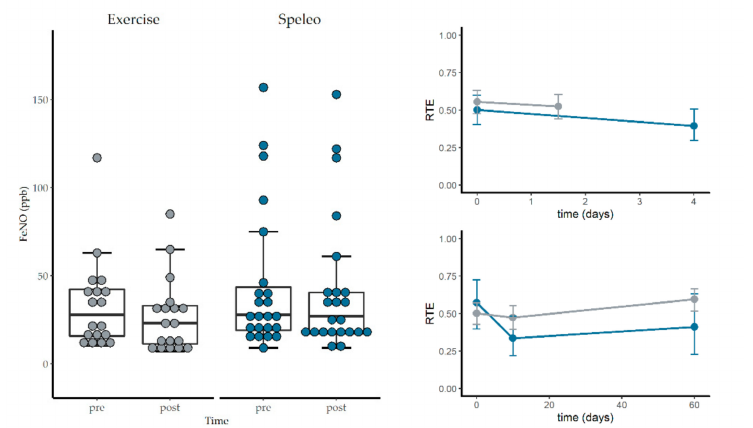
Figure 4. Short term e ff ects of winter exercise on fractional exhaled nitric oxide. Exercise group is colored grey and speleotherapy group is colored blue. Upper right plot shows the relative treatment e ff ects of the short-term measurements of FeNO. The lower right plot shows the relative treatment e ff ects of FeNO over all time points (day 0–day 60). Error bars represent upper and lower confidence interval of the relative treatment e ff ects